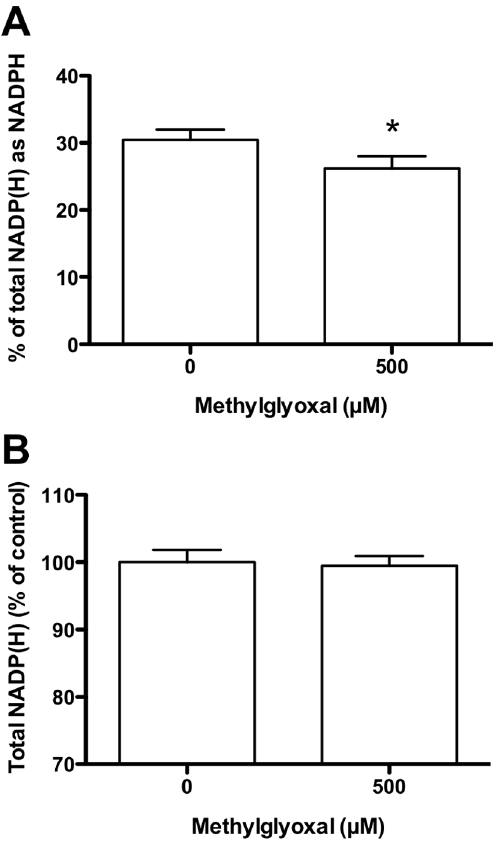
Figure. 3. NADPH levels in HCAEC following incubation with MGO. HCAEC were incubated with 0–500 m M MGO in serum-free medium for 1 h at 37 u C, prior to lysis and analysis. (A) Percentage of NADP(H) that is present in the reduced form (NADPH). (B) Total NADP(H) pool (NADP + + NADPH). Data are means + SEM of 3 independent experiments each performed in triplicate. *Significant change ( P , 0.05) compared to 0 m M control (paired t -test of log-transformed data). F6P to measure G6PD + 6PGD + H6PD activity (Figure 5C;